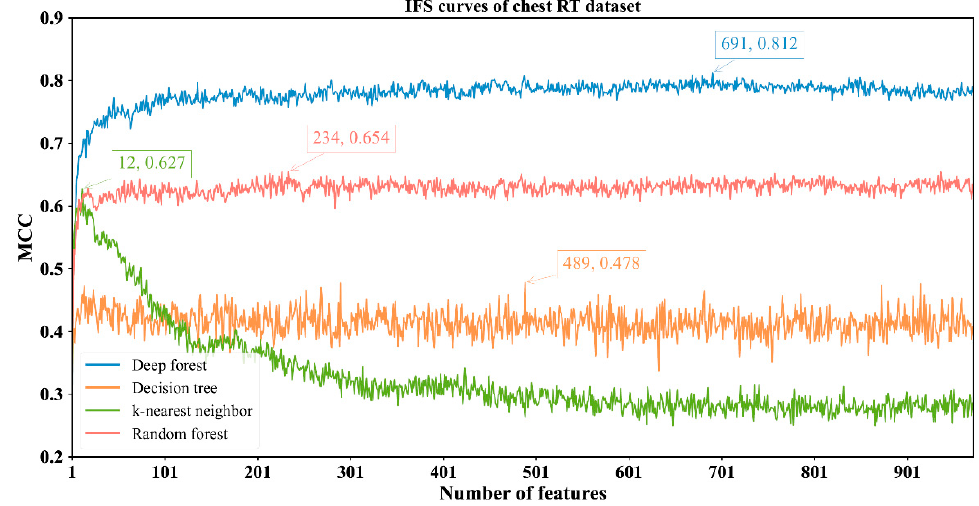
Figure 4. IFS curves with different classifiers on the different numbers of methylation features for chest RT methylation dataset. DF reaches the highest MCC value of 0.812 when the top 691 features are adopted.